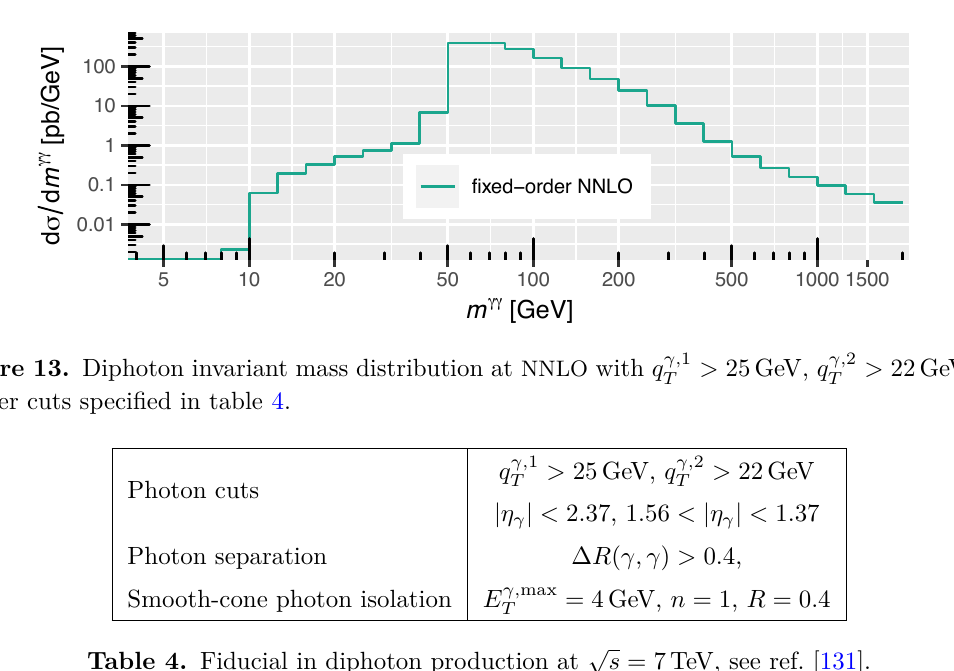
Table 4. Fiducial in diphoton production at